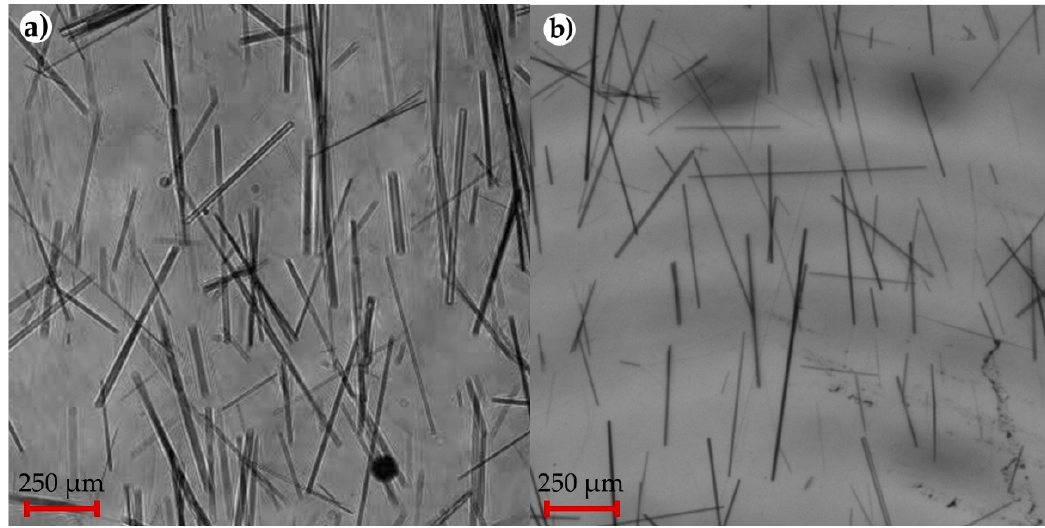
Figure 12. Thiamine hydrochloride (t = 1 h) monohydrate crystals ( a ) online microscope ( b ) shadowgraphic probe. The images are enlarged for a better view of the edges.